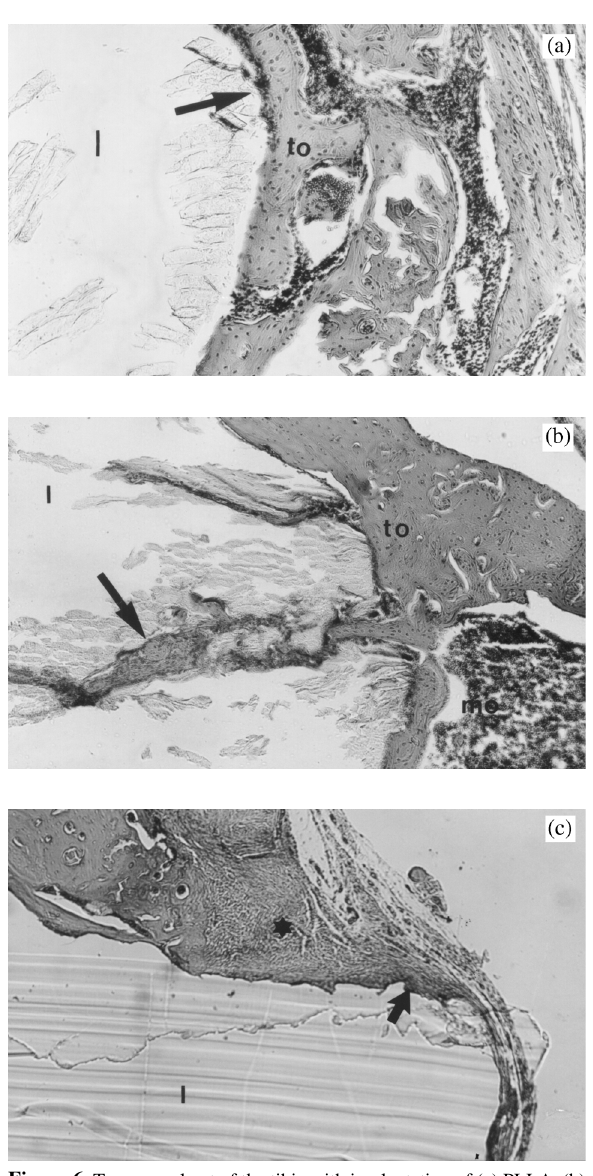
Figure 6. Transversal cut of the tibia with implantation of (a) PLLA, (b) PLLA/PEO blend and (c) PVC after 4 weeks post-surgery. In (a) it is possible to note the cellular proliferation between the bone and the implantation (arrow). In (b), the bone formation on the inside of the implant (arrow) can be noted. In (c), it is possible to observe a fibrous tissue (star) and inflammatory infiltration (arrow). Implantation (I), bone tissue (to) and bone marrow (mo). 3.2x10